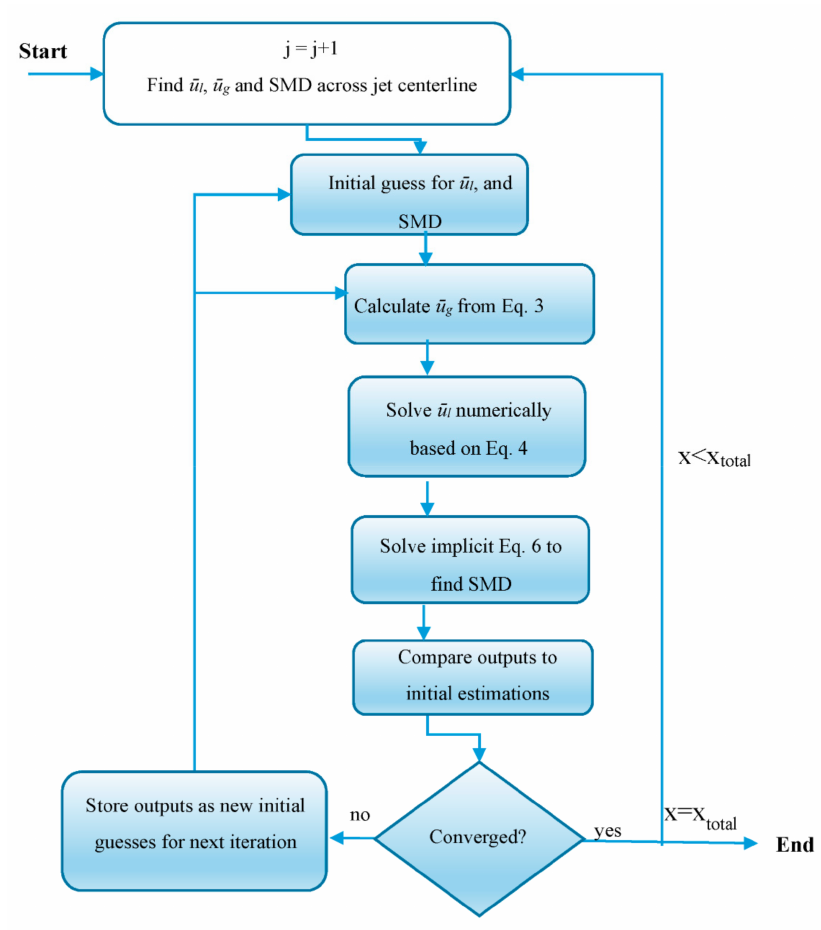
Figure 3. The employed algorithm to numerically obtain ¯u l , ¯u g and SMD across the jet